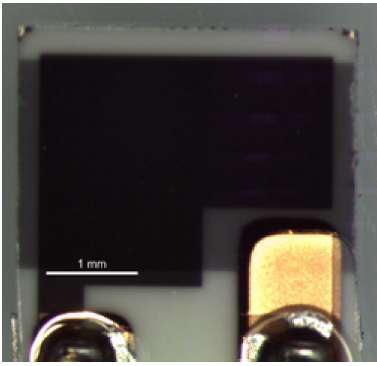
Table 2. List of tested polymer-based humidity